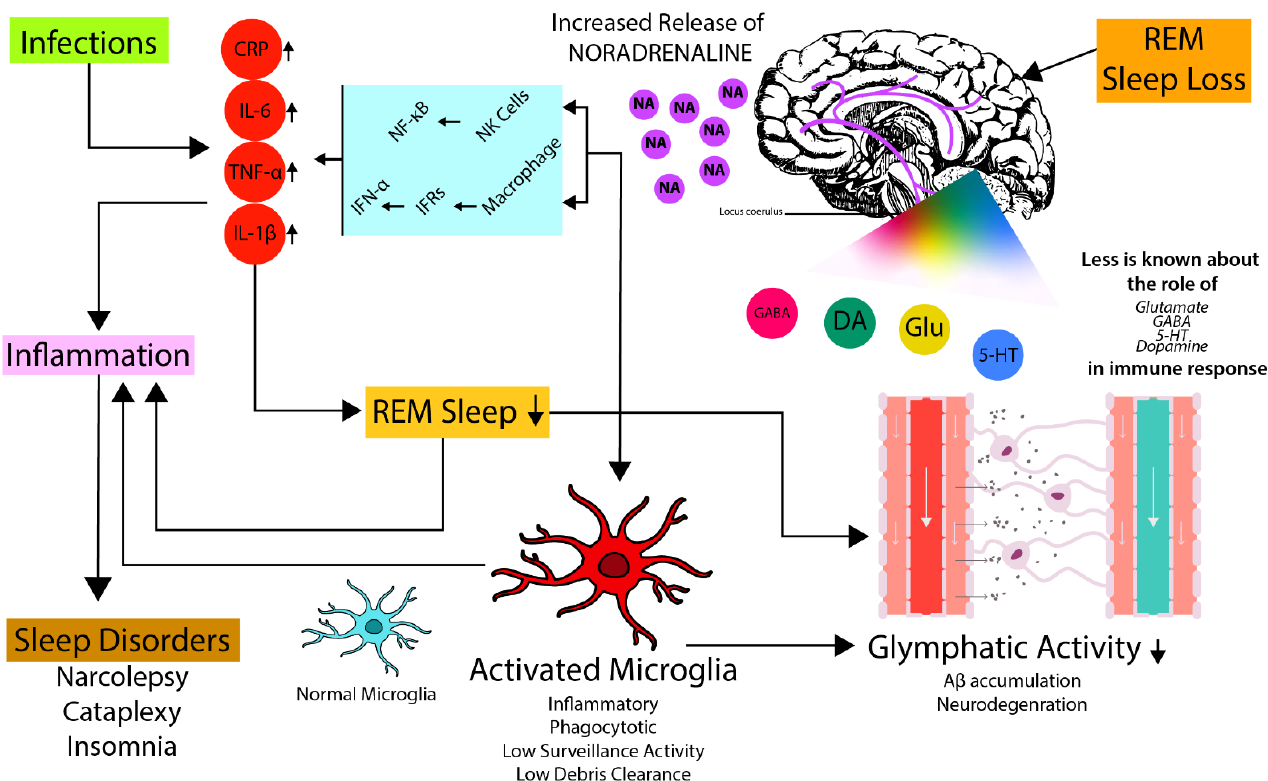
Figure 1. REMS maintains optimum NA levels in brain. During sleep (which also includes REMS) loss, there is an increased NA release in the brain (Mehta et al., 2017) which mediates macrophages and NK-cell activity. Increased macrophage activity leads to increased cytokine levels (IL-6, TNF- α , IL-1 β ) via NF- κ B signaling resulting in inflammation (Sugama & Kakinuma, 2021; Sugama et al., 2019). Both increased cytokine levels and noradrenaline provide favorable conditions for microglial activation (Liu et al., 2019). Activated microglia leads to attenuated glymphatic activity (Benveniste et al., 2019; Leng et al., 2021), which elevates neuroinflammation and causes neurodegeneration. Neuroinflammation-induced cytokines further inhibit sleep (Okun et al., 2004; Kheirandish-Gozal & Gozal, 2019).